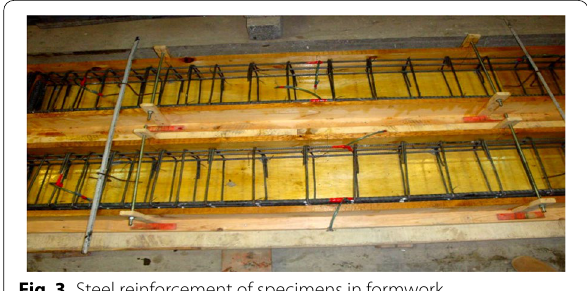
Fig. 3 Steel reinforcement of specimens in formwork.